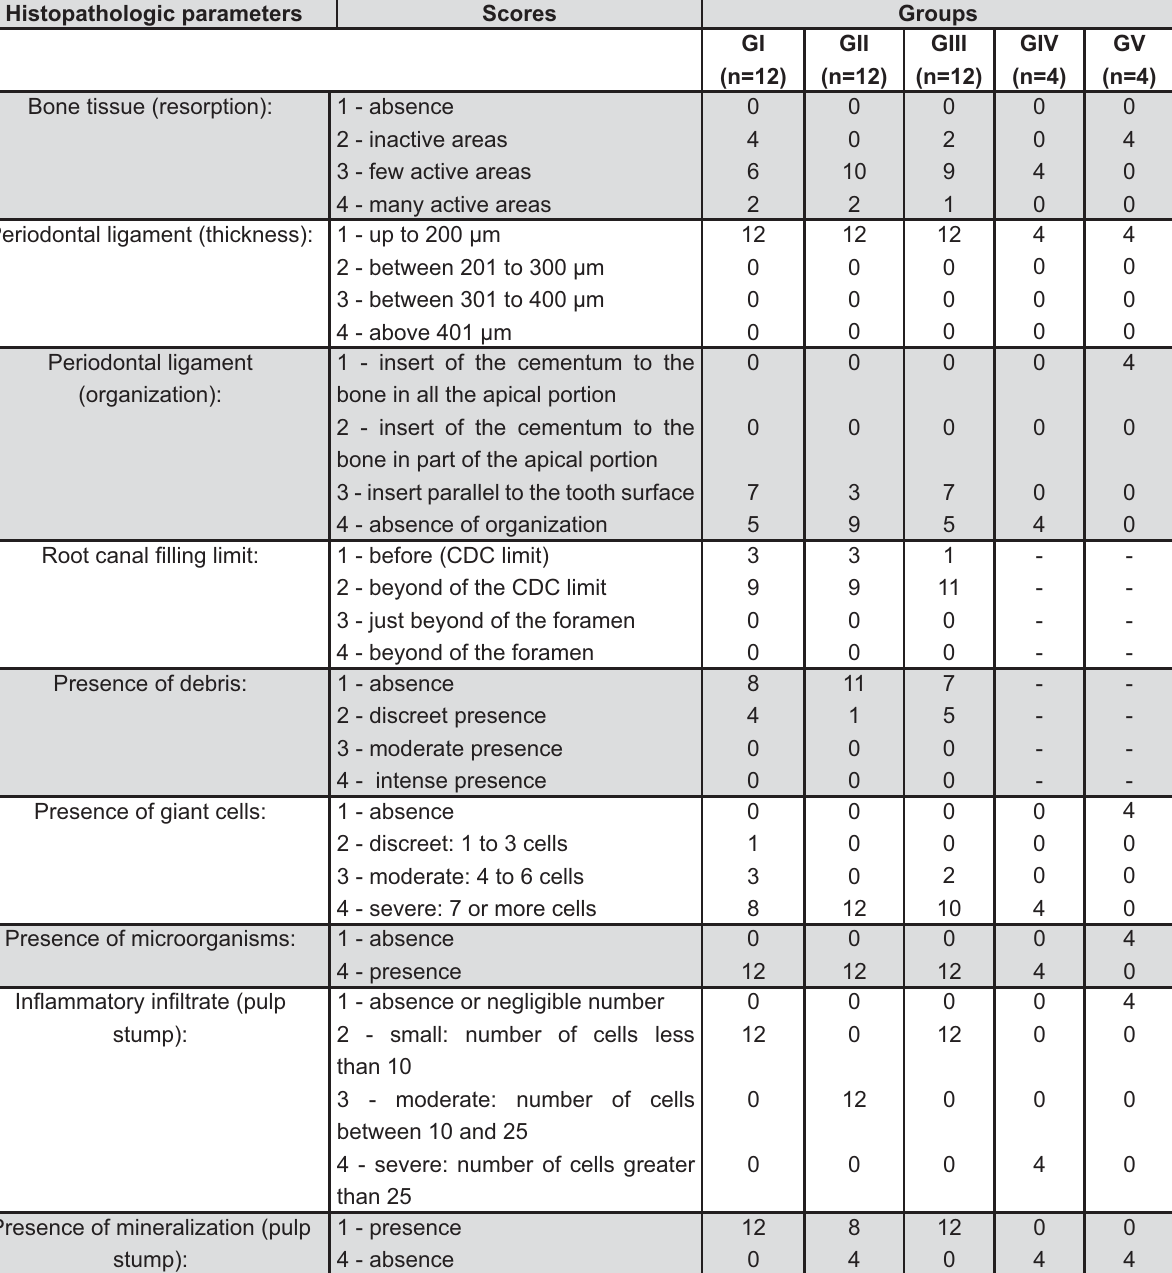
Figure 7- Specimens distribution by group according to the scores of histopathologic